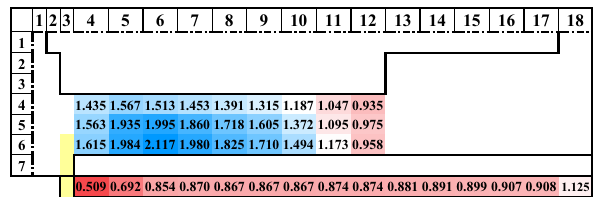
Table 2. The BOP table for the M@Ce 12 O 8 36+ cluster models is arranged according to the period and group of the periodic table. When the maximum value (2.117) is set to blue and the minimum value (0.509) to red, each cell is colored by gradient according to the obtained BOP value, blue and red for larger and smaller values, respectively.